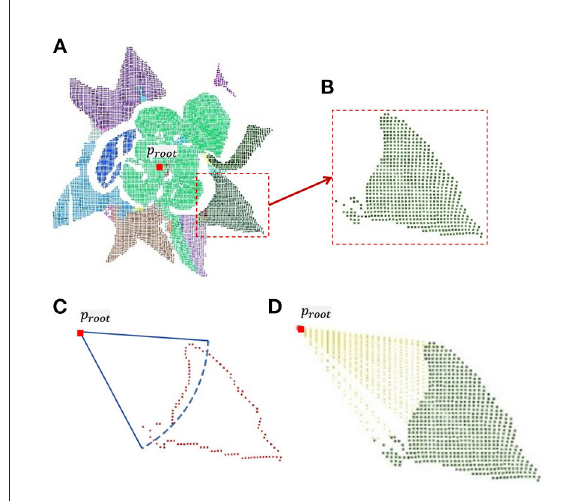
FIGURE3 Completion of a single leaf point cloud. (A) Leaf point clouds were obtained from plant point cloud by color-based region growing segmentation. (B) Symmetrical leaf point cloud. (C) According to the calculated threshold, the edge points in the leaf point cloud are determined. (D) Result of uniform sampling between edge points and root point.